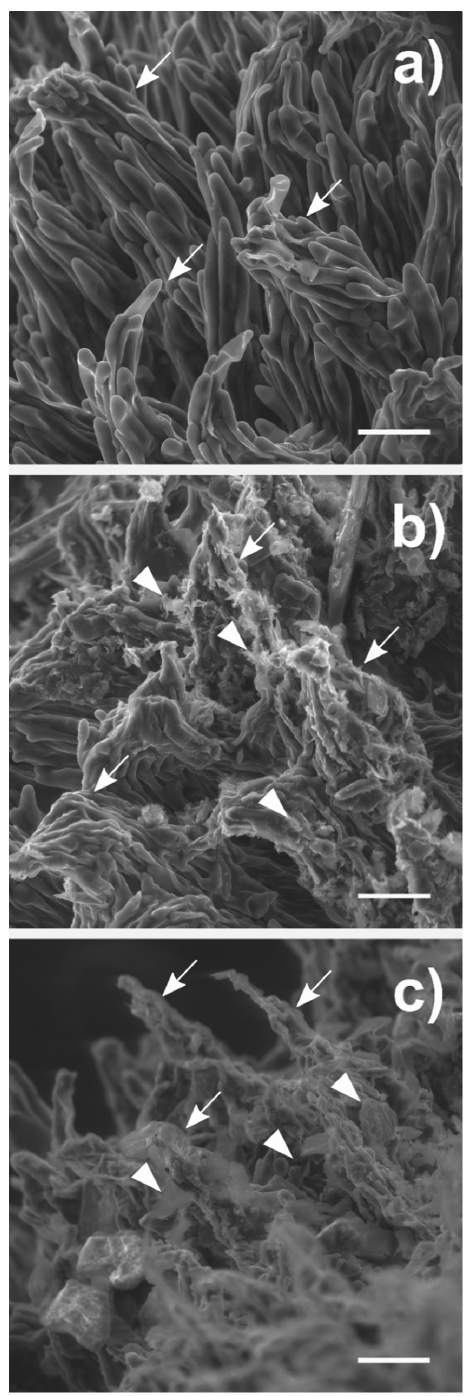
Figure 2. ( a ) SEM micrographs of stigmatic surfaces of Cucurbita pepo L. female flowers treated for three hours without nanomaterials (CTRL); ( b ) with 1 mg of few-layer graphene (FLG); ( c ) with 1 mg of muscovite mica (MICA). Stigmatic papillae are indicated with arrows, nanomaterials with arrowheads. Bars = 100 µm. For further images, see Figure S4.